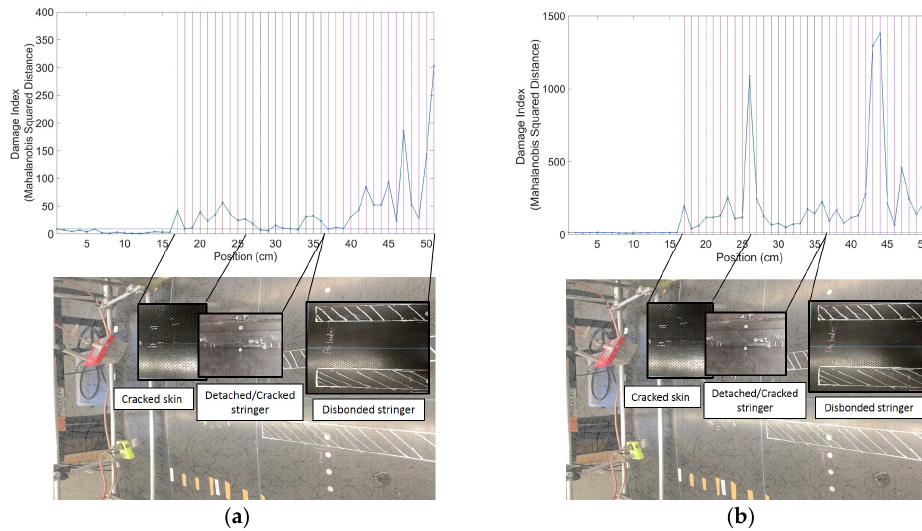
Figure 9. Representative results from non-contact (air-coupled) UGW scans of Panel 3: ( a ) skin modes only; ( b ) skin modes plus stringer modes.